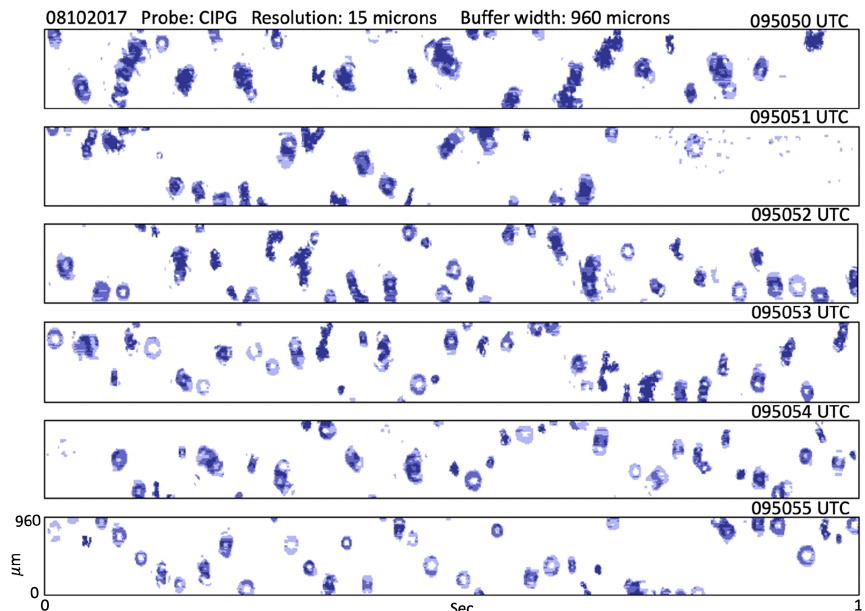
Figure 2. Snapshots of ice particle images from the CIPg probe during Flight 8 (F8). Each slide has a height of 960µm and length of 1s.